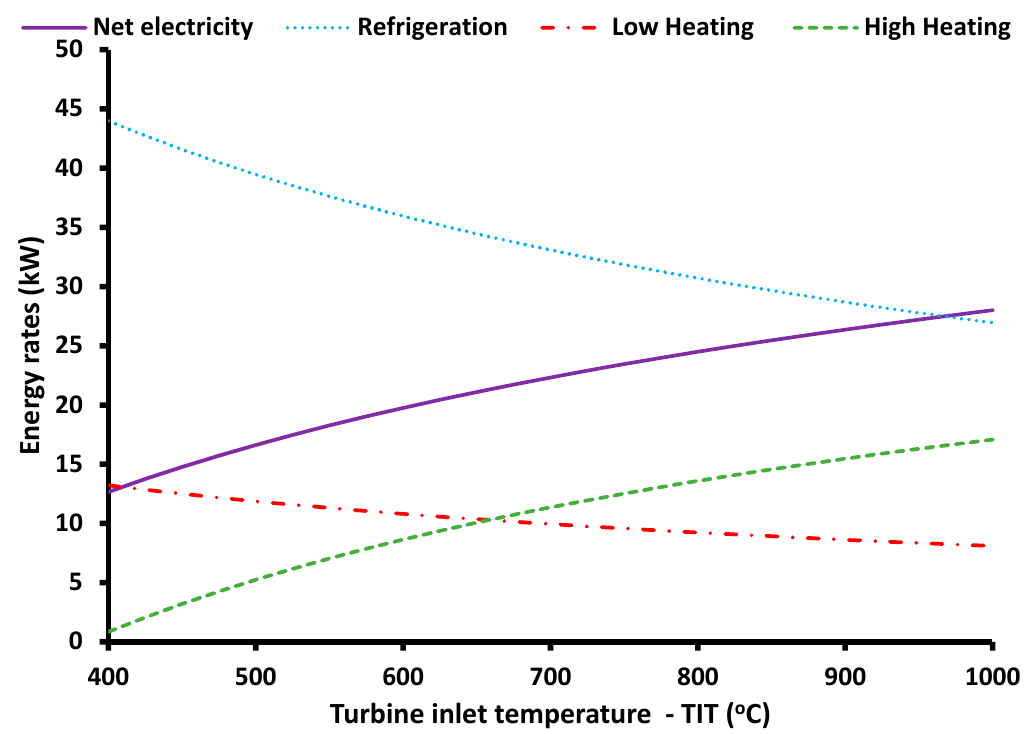
Figure 4. Useful energy products for different values of the turbine inlet temperature.